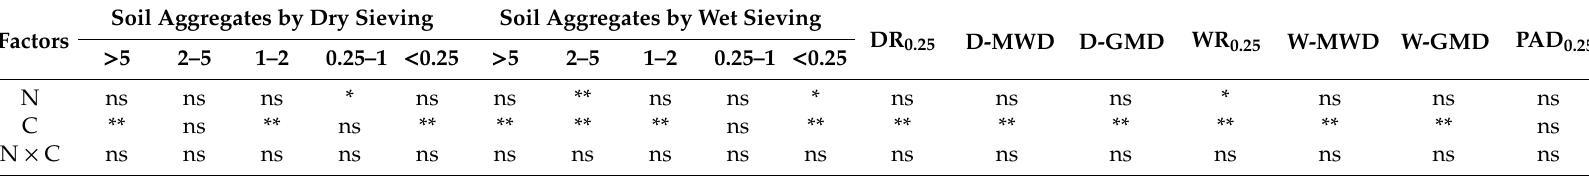
Table 1. Results of two-factor ANOVA (F values) with biochar and nitrogen fertilizer as independent factors for changes in soil attributes. Factors